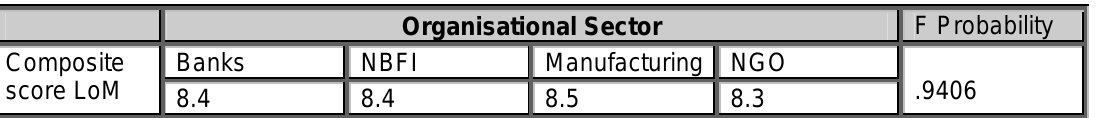
Table 5: Oneway ANOVA on level of